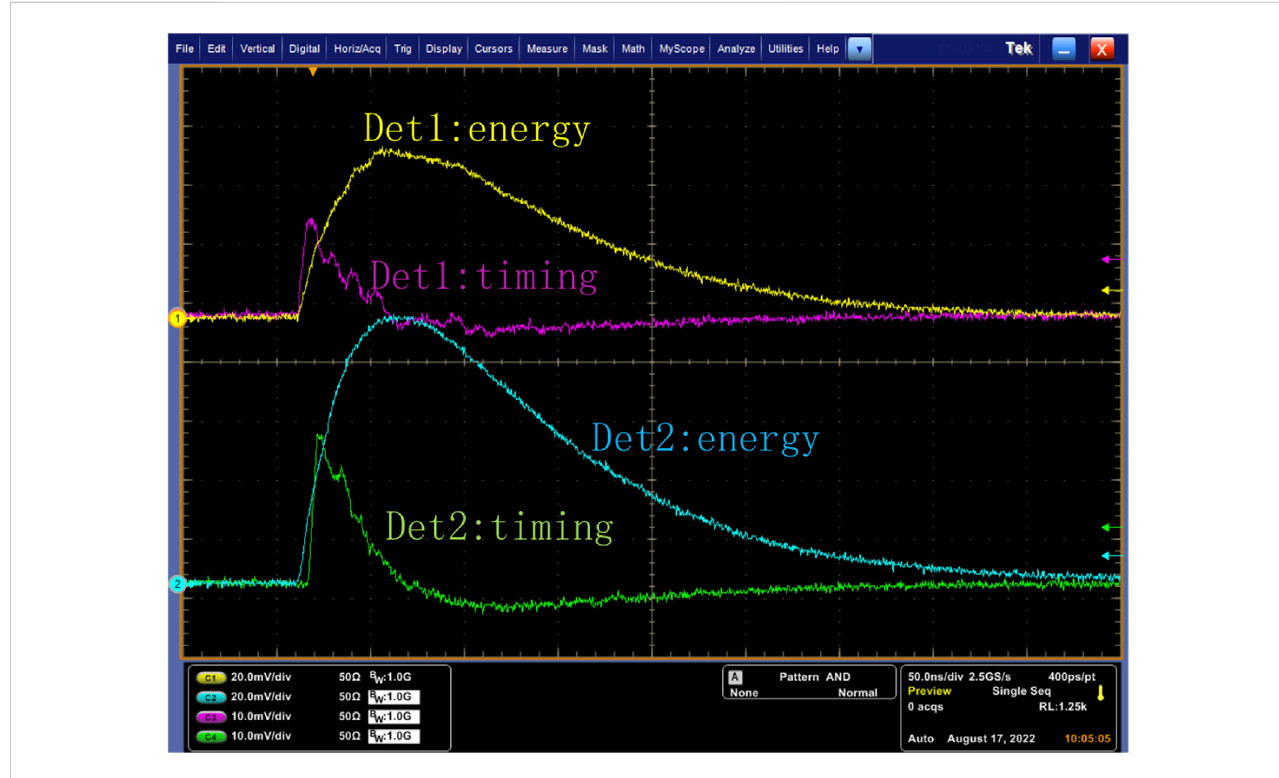
Typical waveforms of a coincidence event captured by the